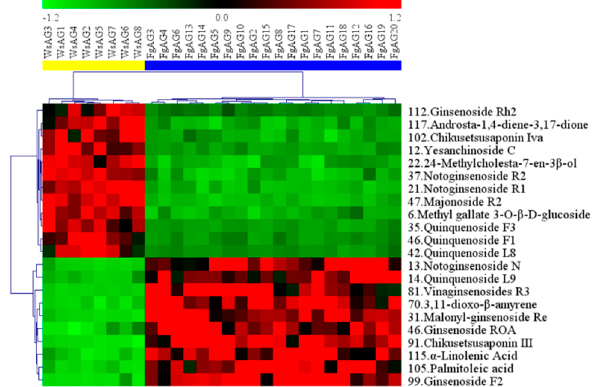
Figure 6. The heatmap visualizing the intensities of potential biomarkers.